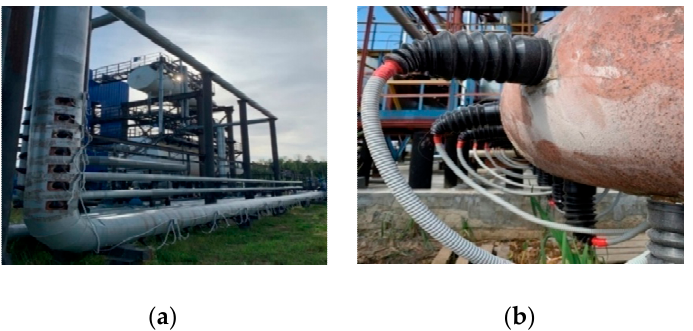
Figure 16. Industrial application of ultrasonic exposure to COPP in Western Siberia (Russia): ( а ) belts of ultrasonic pathogens; ( b ) ultrasonic exciters.